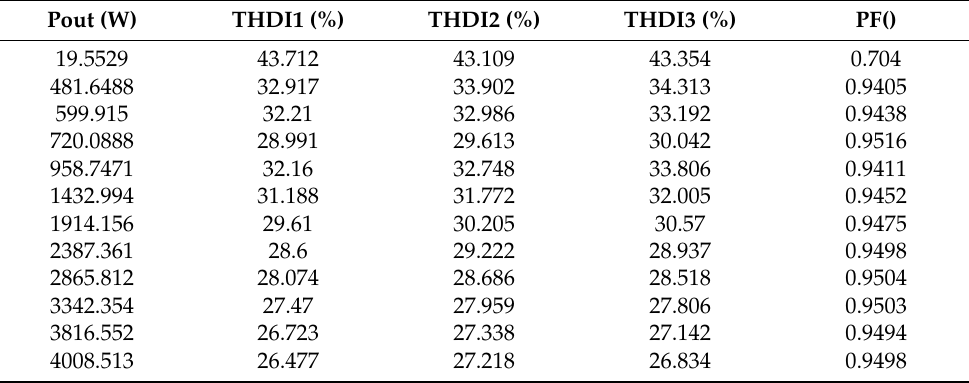
Table A4. THD and PF parameters for original transistor SiC IMZA65R072M1 and ferrite inductor (operating frequency 200